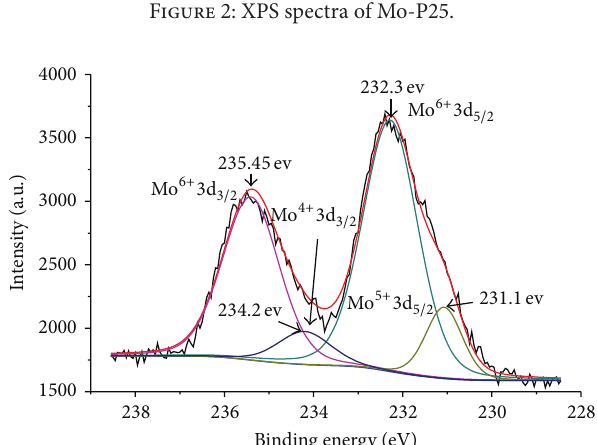
Figure 2: XPS spectra of Mo-P25.